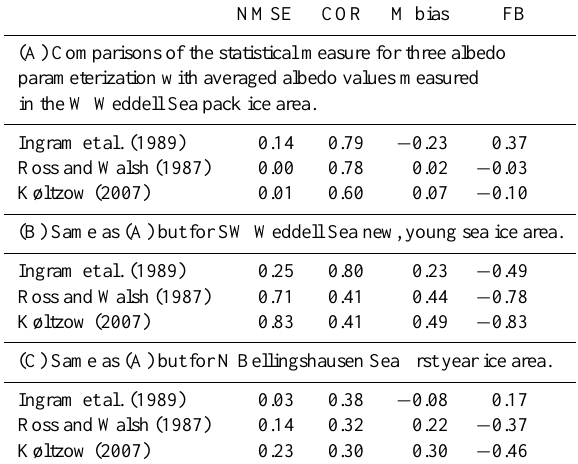
Table 4. Statistical measures compared for three different sea ice areas (as listed in Table 1) and three different parameter- izations (as listed in Table 3). The statistical measures are NMSE=the normalized mean square error, COR=correlation coef- ficient, M Bias=Model bias, and FB=fractional bias ranging from ±